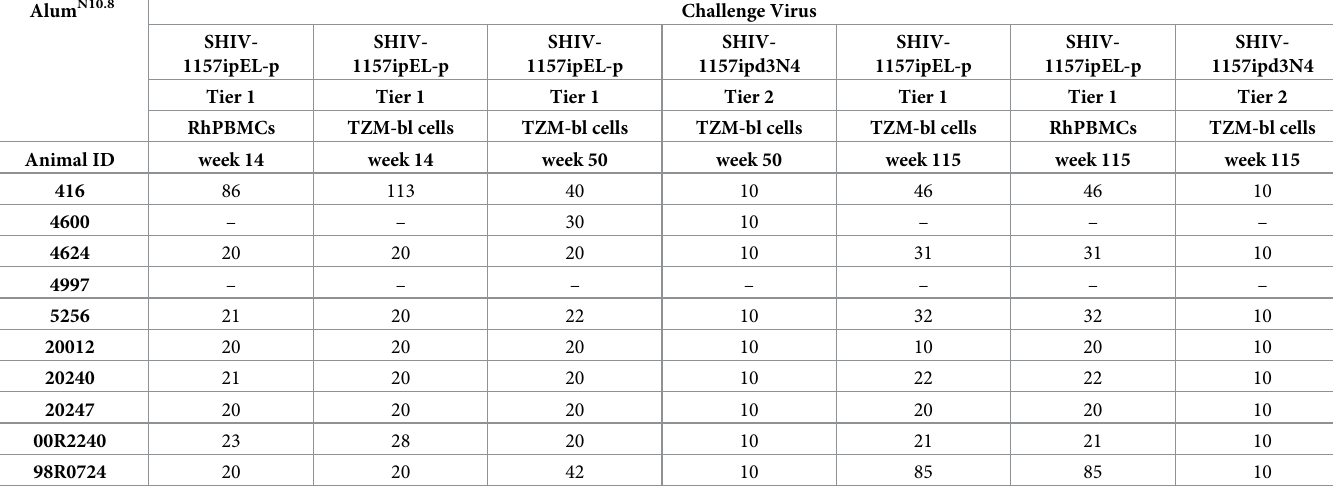
Table 6. Serum neutralizing activity against SHIV-C challenge stocks in animals immunized in Study 2 (Alum N10.8 ). Alum N10.8